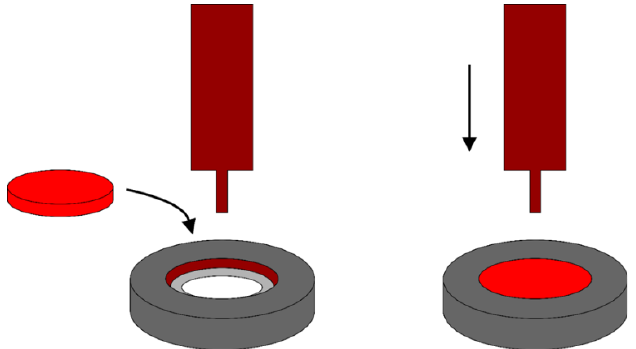
Figure 2. Scheme of the biaxial flexure strength test.